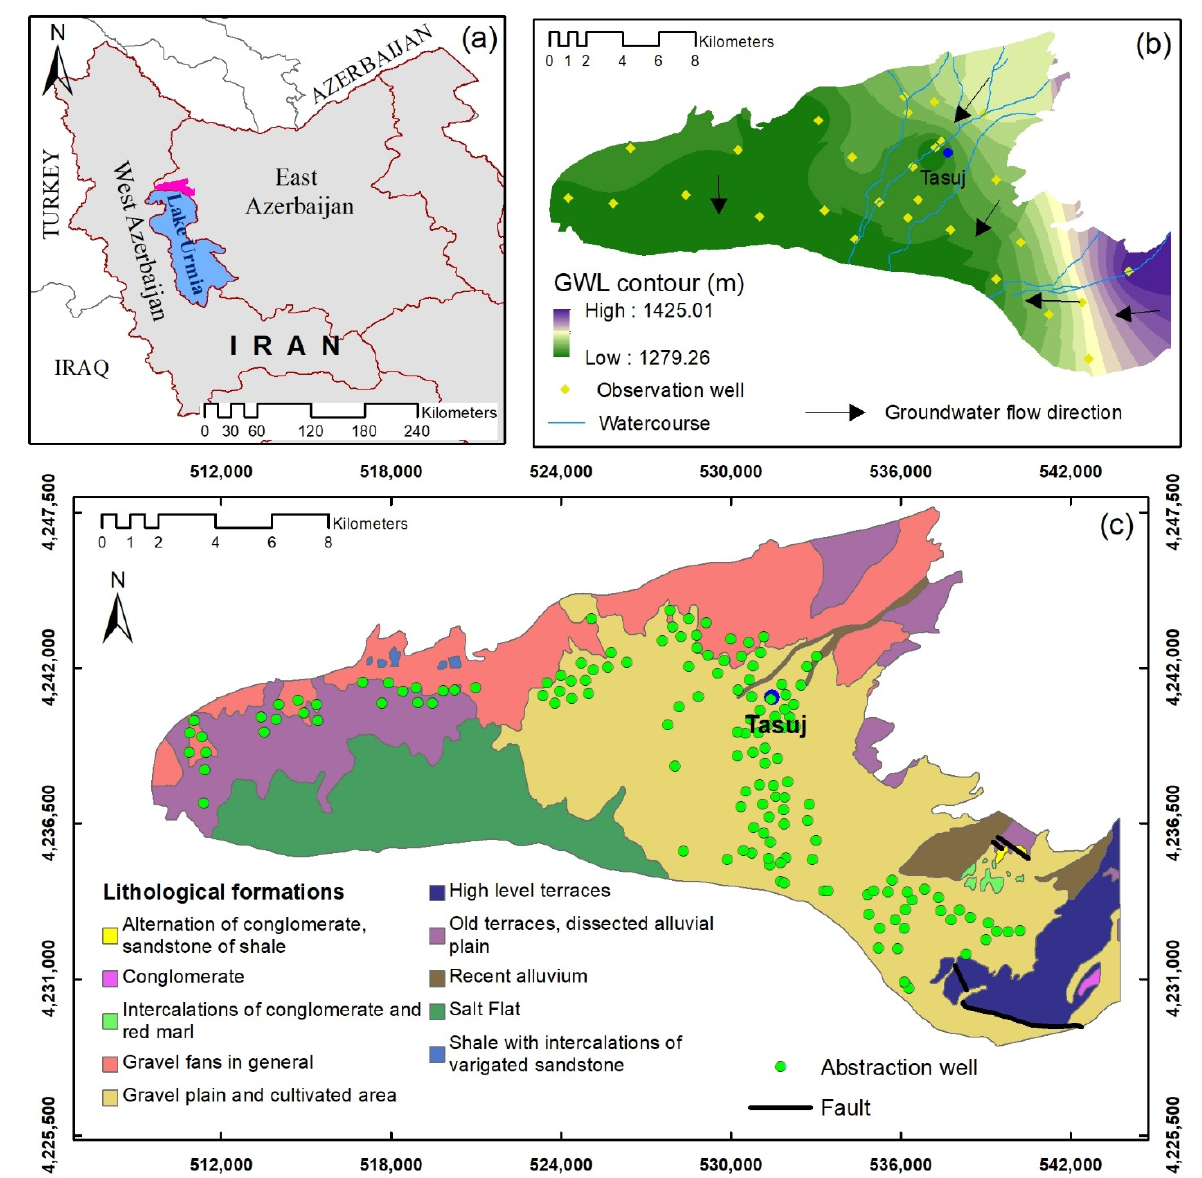
Figure 2. Study area: ( a ) location map; ( b ) GWL and observation wells; ( c ) lithological map and abstraction wells.